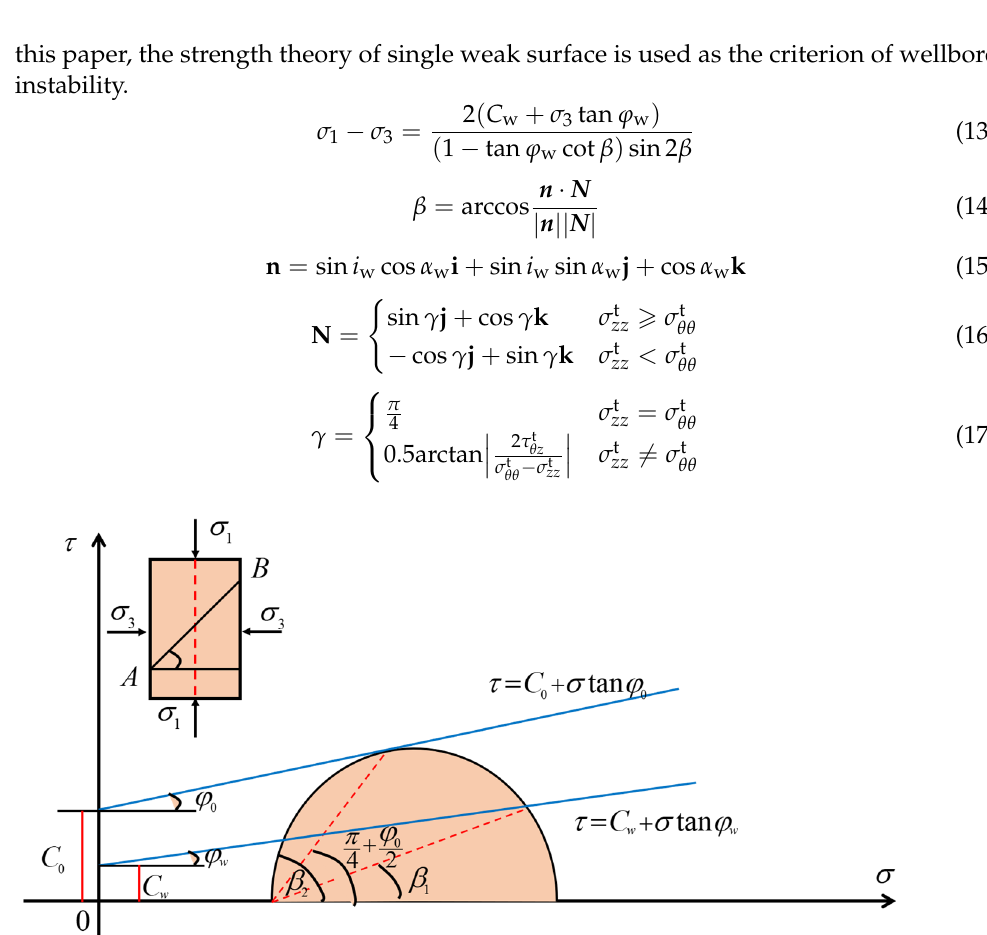
Figure 6. Schematic diagram of single weak plane strength theory [38].